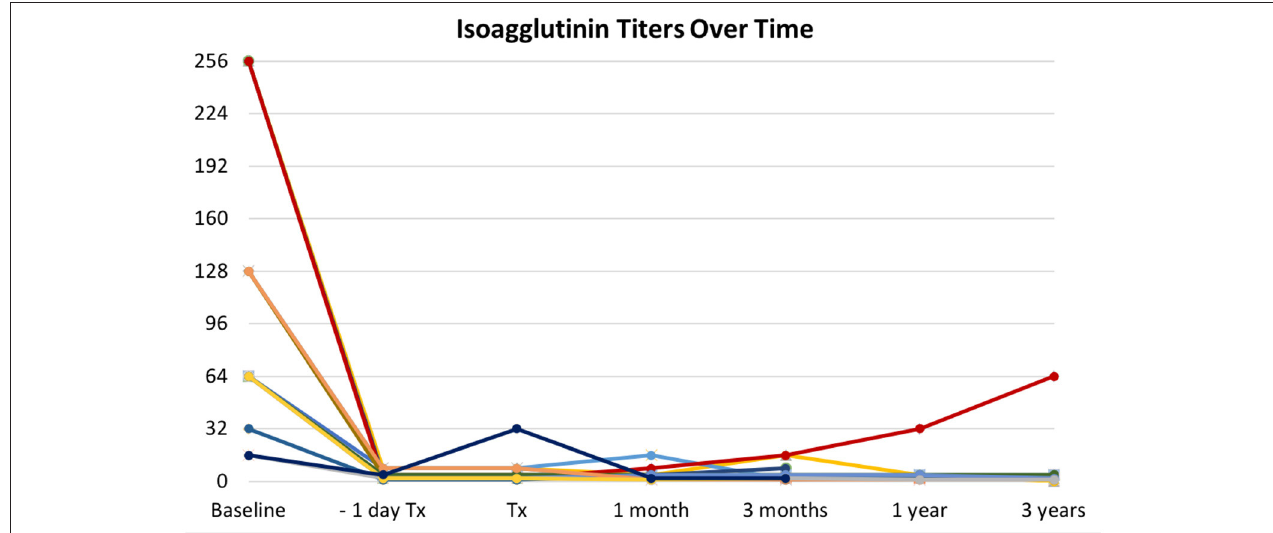
FIGURE 1 | Trends in isoagglutinin titers over time. All patients successfully responded to desensitization protocol, with isoagglutinin titers abated within the day before transplantation (Tx). One patient experienced a sudden rebound the day of surgery (dark blue line). Titers remained stably low or slowly increased during follow-up, with no associated antibody-mediated rejection, accounting for what is defined as accommodation. Different colors in lines account for patients grouped according to the same baseline titers.